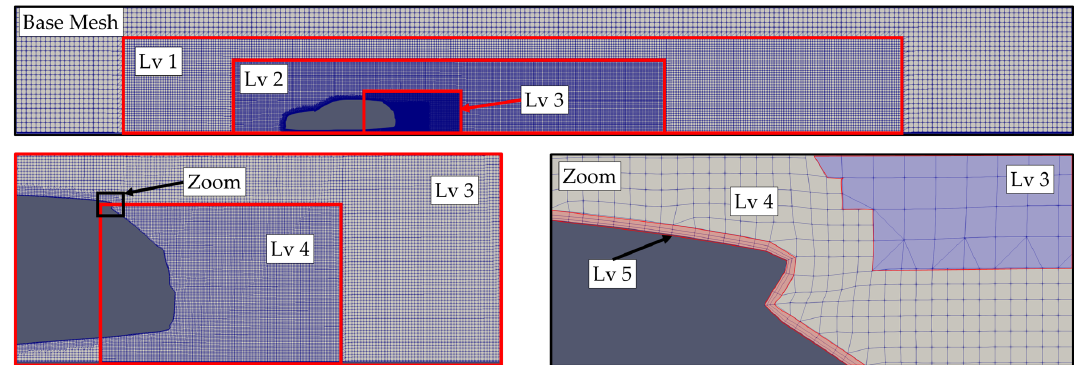
Figure 5. Schematic diagram of the mesh